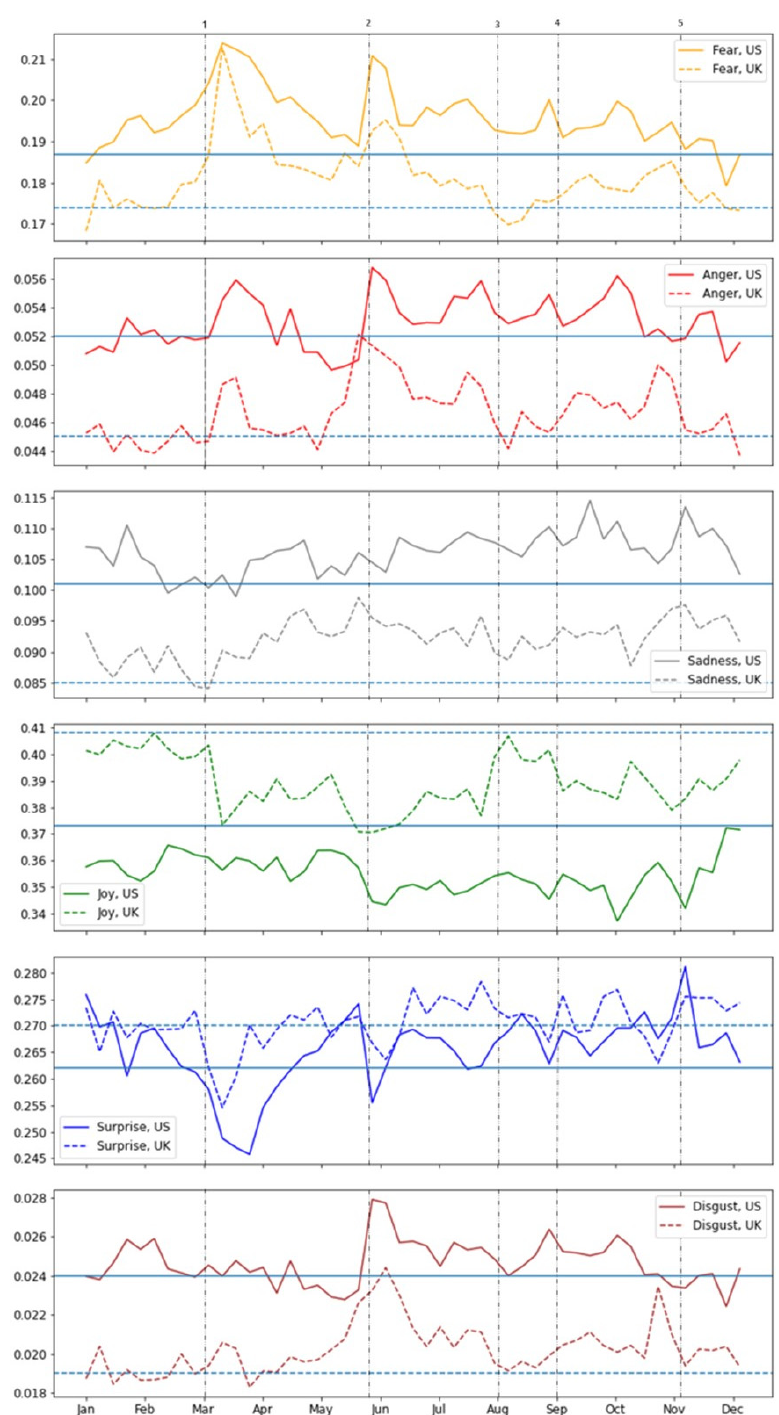
Figure 4. Average weekly emotion values in 2020. Note: the horizontal lines represent the mean score for each country in 2019 (solid—US, dashed—UK). 1—first wave of COVID-19 in the UK and the US; 2—the George Floyd incident; 3—second wave of COVID-19 in the US; 4—second wave of COVID-19 in the UK; 5—US elections.